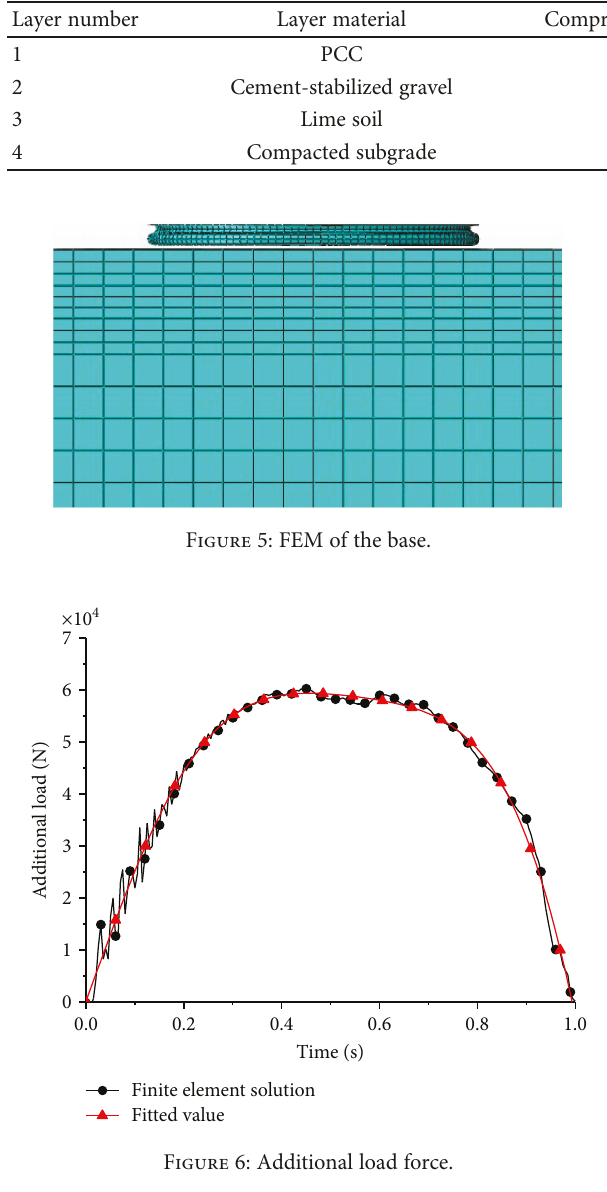
Table 1: Basic parameters of fi eld structure.